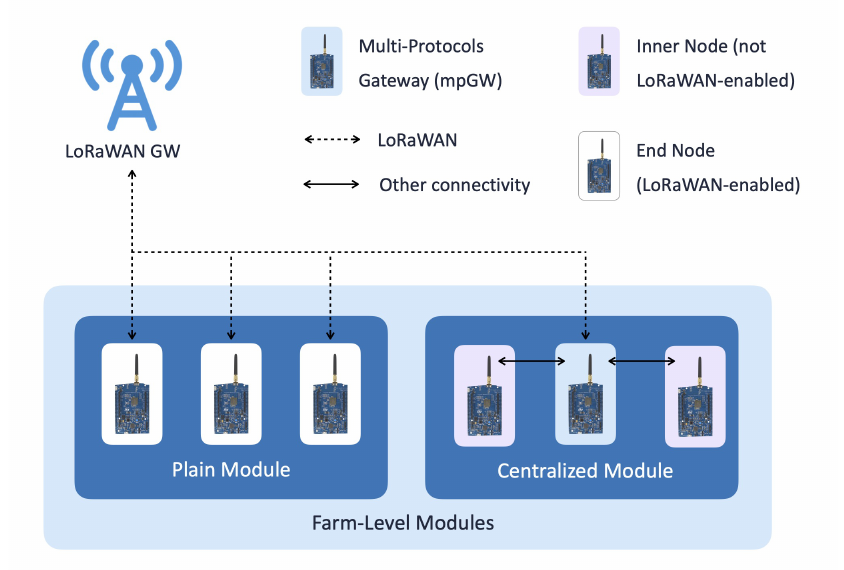
Figure 3. LoRaFarM architecture: the two typologies of farm-level modules.